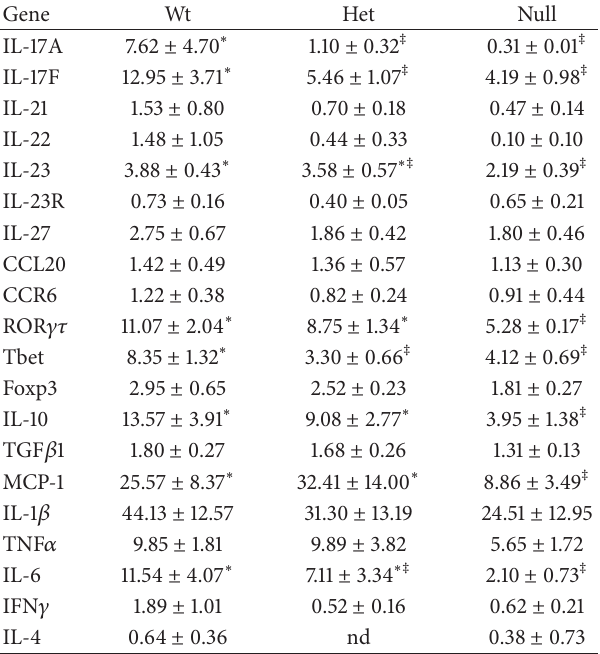
Table 3: Colonic mucosal mRNA expression in Wt and Fat-1 TNBS- treated mice 1 .